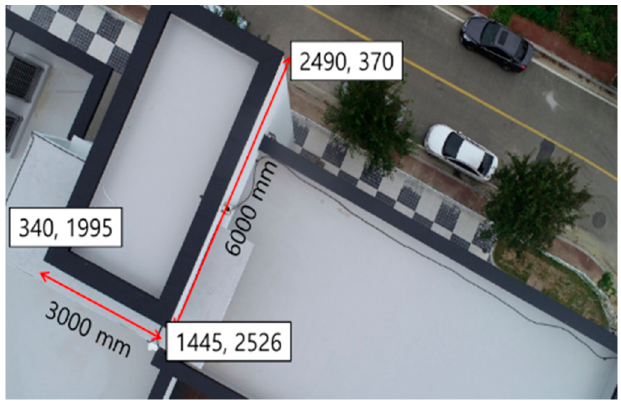
Figure 11. GSD calculation using images and lines. Table 6. GSD accuracy of the simulator.